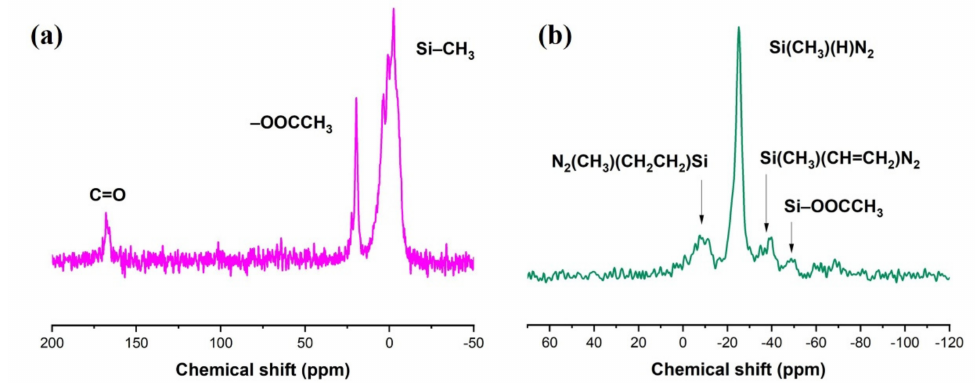
Figure 2. The ( a ) 13 C NMR spectra and ( b ) 29 Si NMR spectra of Du1800-Pd precursor.